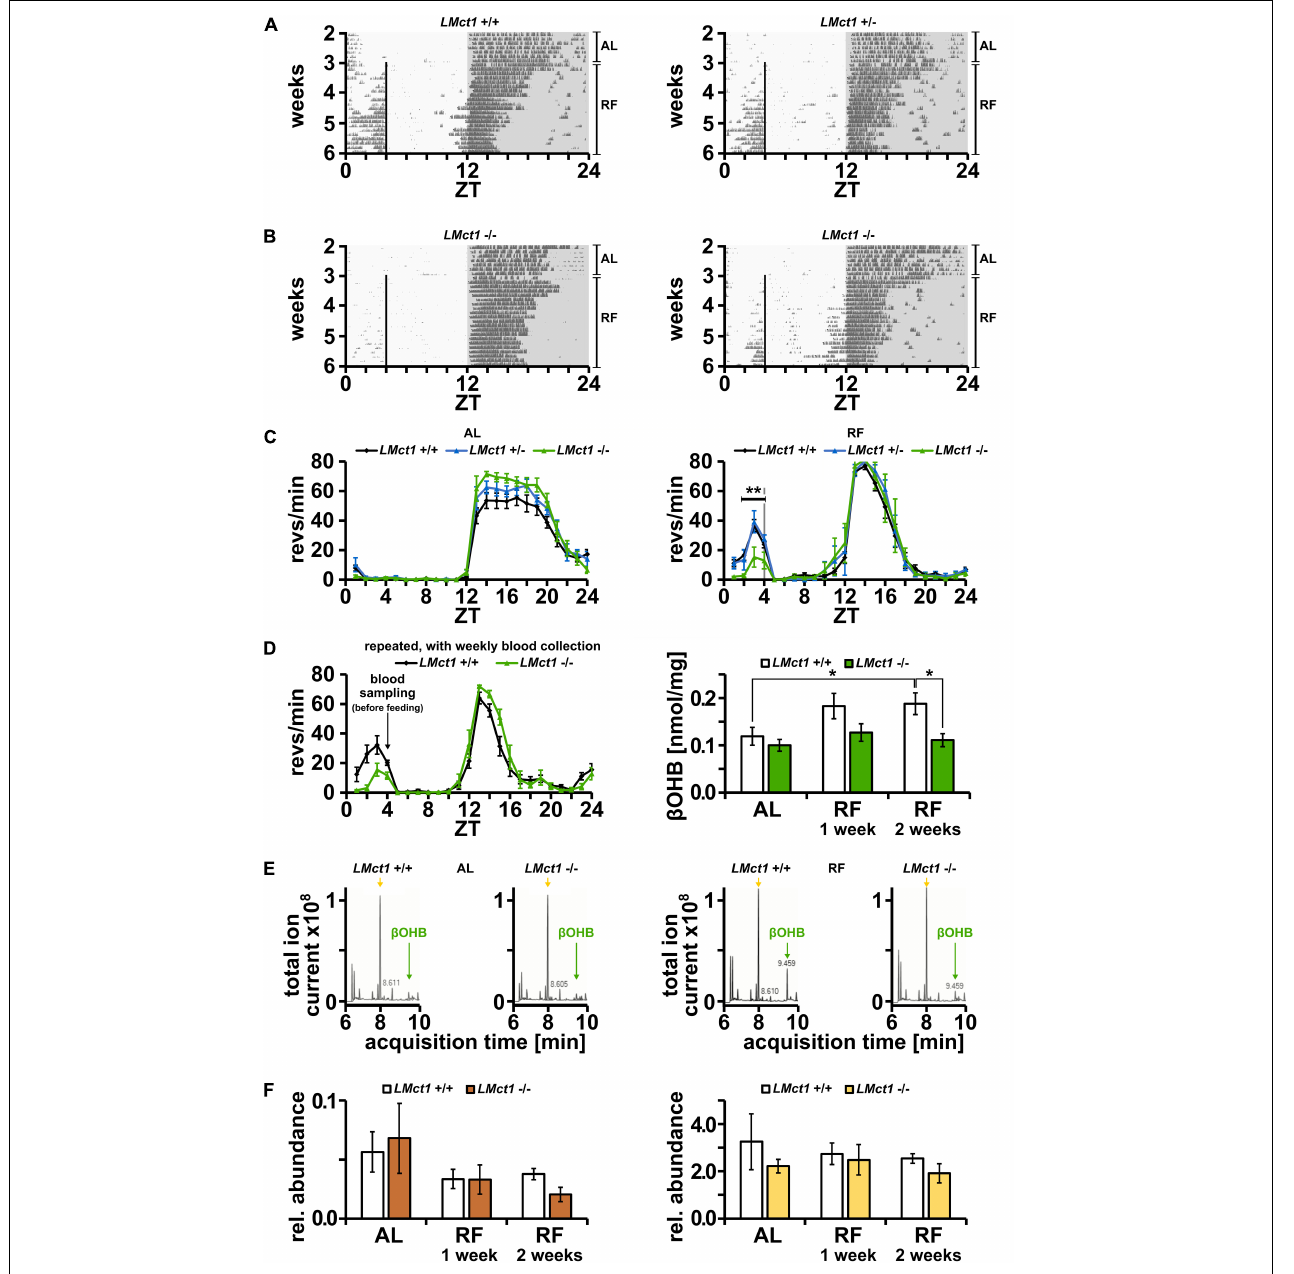
FIGURE 4 | Mice lacking Mct1 in liver display reduced FAA and show reduced β OHB levels. (A) Examples of wheel-running actograms of liver Mct1 control animals ( LMct1 + / + , left panel) and heterozygous liver Mct1 knock-out animals ( LMct1 + / − , right panel) under ad libitum (AL) and the last week of daytime-restricted feeding (RF) conditions. The vertical line at ZT4 indicates time of food access. (B) Two examples of wheel-running actograms of homozygous liver Mct1 knock-out animals ( LMct1 − / − ) under ad libitum (AL) and day time restricted feeding (RF) conditions. The vertical line at ZT4 indicates time of food access. Note the reduced activity before feeding time. (C) Quantified wheel-running activity plots under AL (left panel) and RF (right panel) conditions. Food anticipatory activity (FAA) under RF is normal in LMct1 + / − (blue) compared to LMct1 + / + mice (black), but LMct1 − / − (green) mice show significantly reduced FAA ( n = 4–15, 2-way ANOVA, ** p = 1.88 × 10 − 3 , F = 10.71). (D) Quantified wheel-running activity plots (left panel) of an additional experiment of LMct1 + / + (black) and LMct1 − / − (green) animals under RF conditions ( n = 4–8), from which blood was drawn at ZT4 just before feeding. Their blood β OHB levels under AL and RF conditions (right panel) show that β OHB levels significantly increase under RF conditions in control mice ( LMct1 + / + ; p = 0.04), whereas these levels stay low in LMct1 − / − animals and do not significantly increase ( n = 4–8, 2-tailed t -test, * p < 0.05). (E) Examples of representative β OHB measurements using mass spectrometry under AL (left panel) and RF (right panel) conditions. Green arrows at 9.46 min indicate the peak of β OHB and yellow arrows at 8.00 min indicate the peak corresponding to lactate. Pyruvate, with a retention time of 8.39 min, is not visible in the TIC (amount too low). (F) In contrast to β OHB, relative levels of pyruvate (left panel) or lactate (right panel), expressed as AUC of these molecules compared to the AUC of the internal standard homoserine, do not increase under RF in the control or LMct1 − / − animals. Error bars represent the standard error of